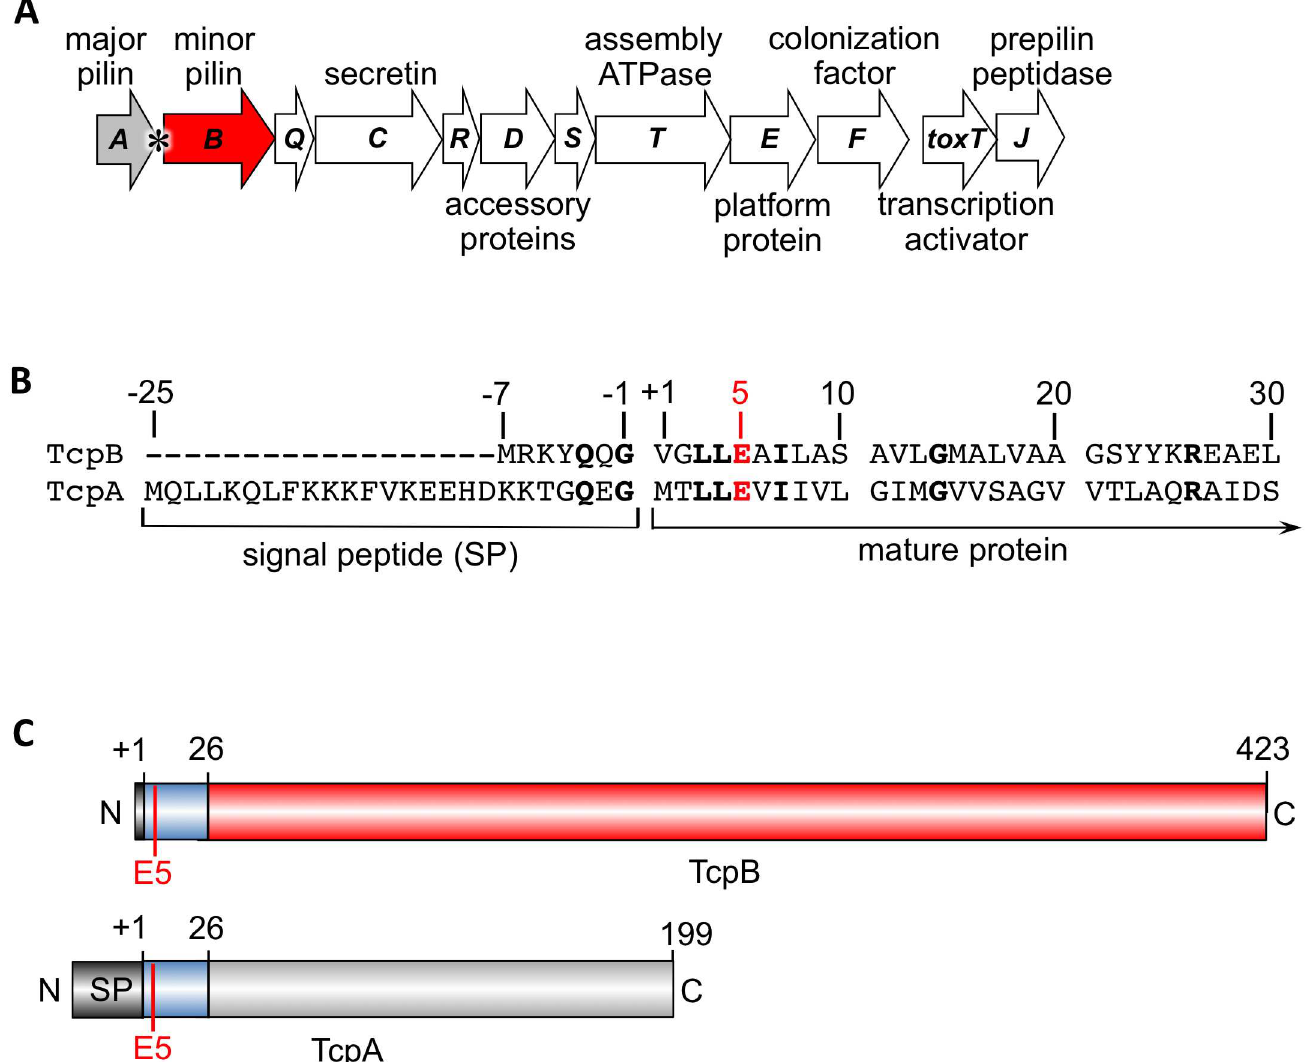
Fig 1. V . cholerae tcp operon and comparison of the minor pilin TcpB and the major pilin TcpA. (A) tcp operonwith the major pilin gene tcpA colored grey and the minor pilin gene tcpB colored red. The putative rho-independent transcription terminator is indicatedwith an asterisk. (B) Amino acid sequencealignmentbetweenthe signalpeptideand the N-terminal 30 residuesof TcpB and TcpA (NCBI accession, CAA45456 and CAA45455, respectively). (C) Schematic of TcpB and TcpA pre-proteins.